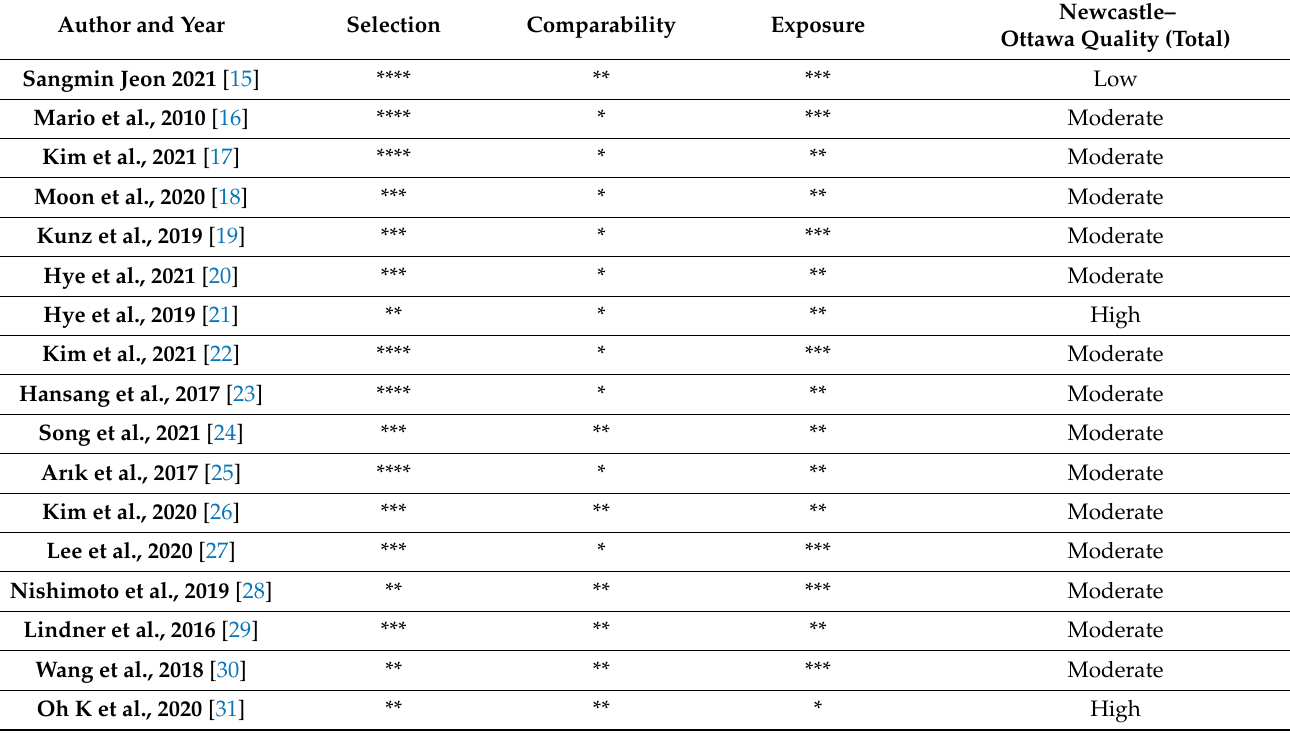
Table 3. Newcastle–Ottawa scale-based quality assessment of the selected studies ( n =